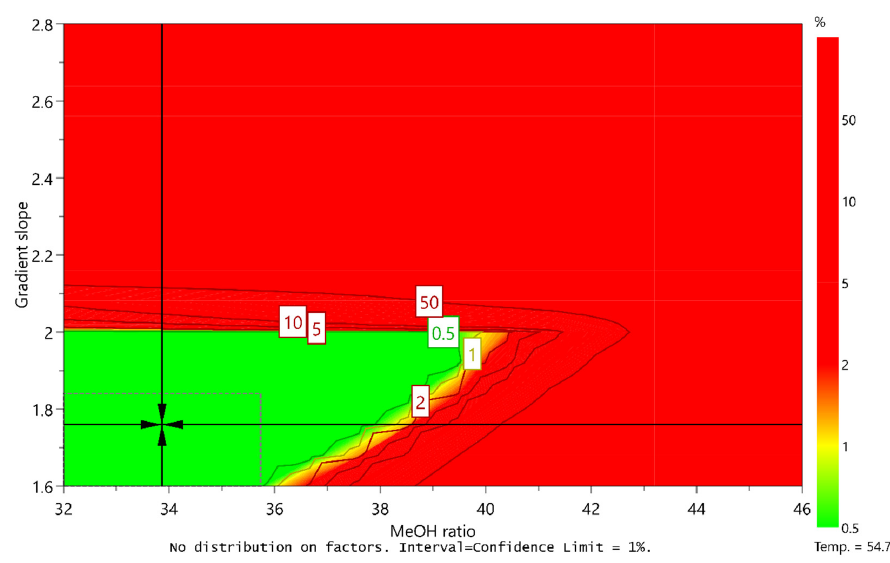
Figure 6. Design space for a central composite face-centered design MLR fitted model when unknown degradation impurity is eluting before impurity C by plotting the ratio of methanol in MP B versus gradient slope at a column temperature of 54.7 °C. Predicted optimal conditions of CMPs are marked with a cross and the defined robustness region is marked with a dashed line.